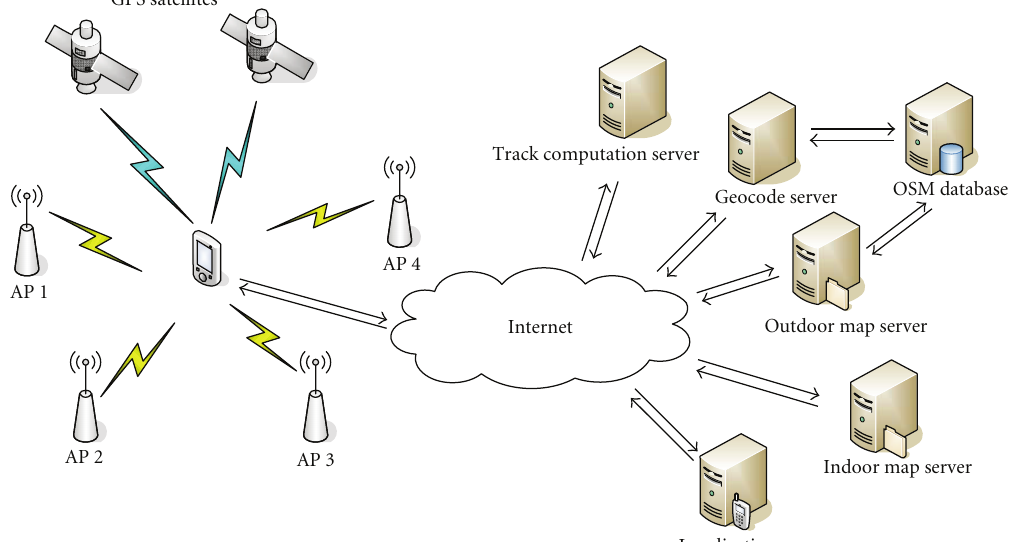
Figure 2: Concept of proposed navigation system.